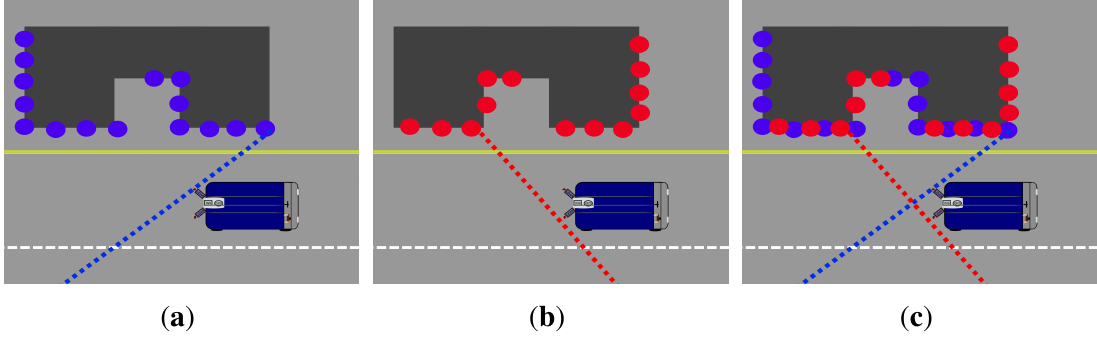
Figure 3. Benefits of a dual scanner system: ( a ) single scanner on left hand side results in data shadows, ( b ) single scanner on right hand side also results in data shadows but in alternate areas, ( c ) dual scanner system fills data shadows with laser